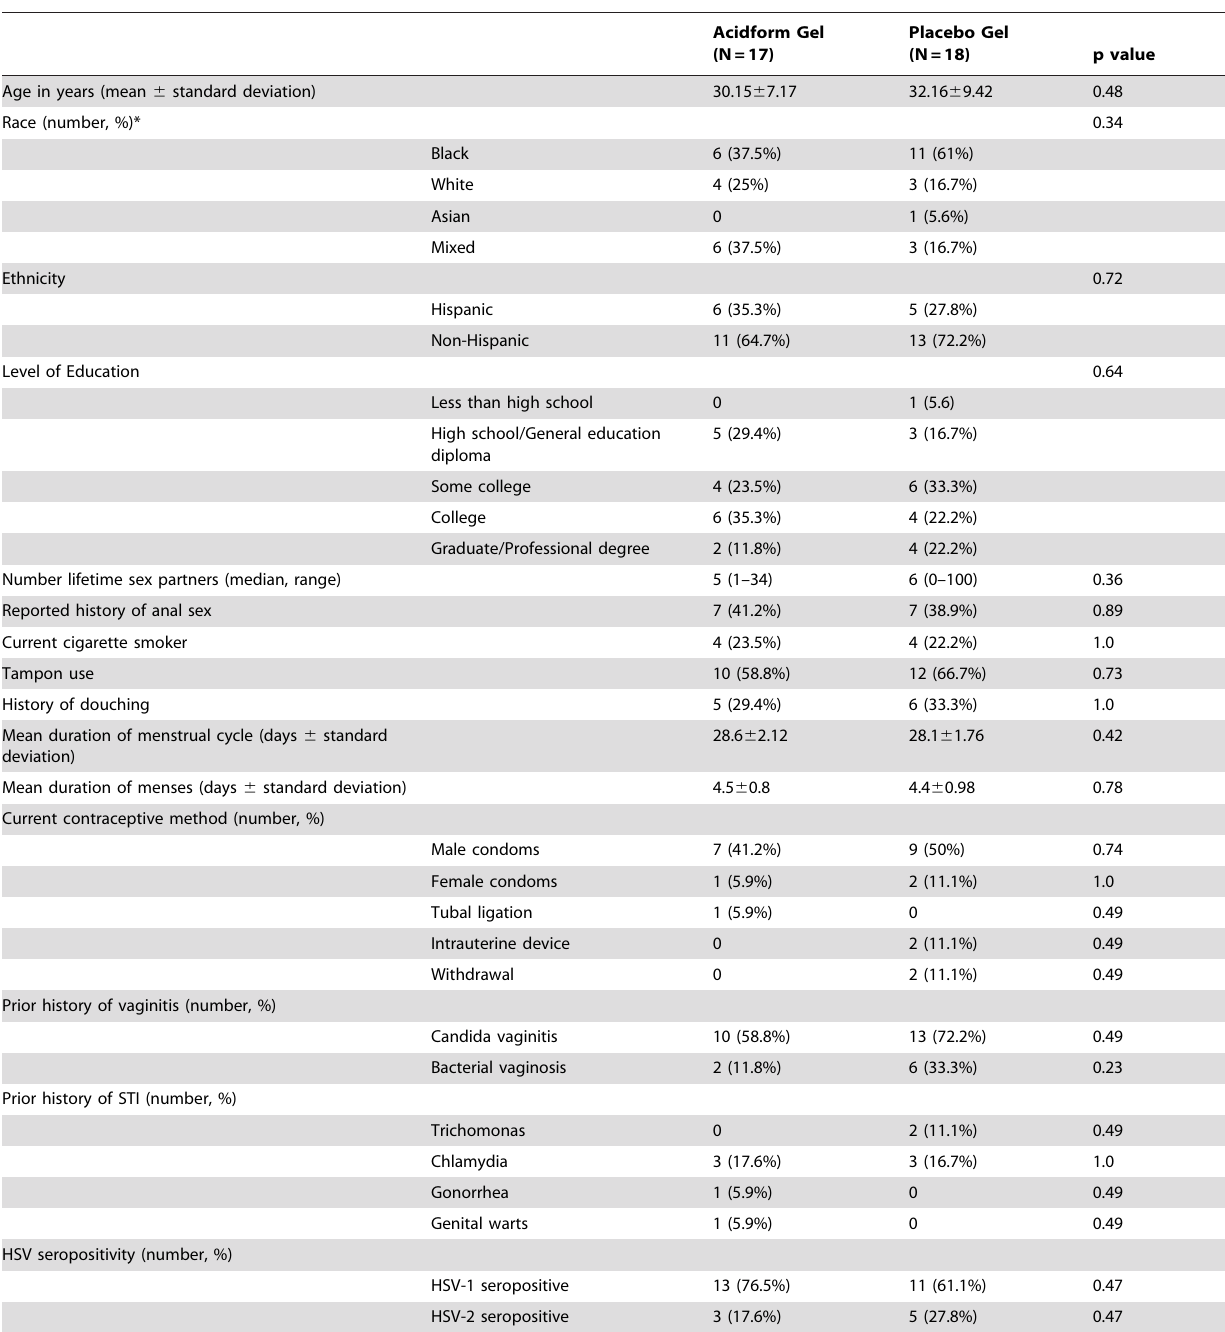
Table 1. Demographic data of recipients of Acidform and HEC placebo